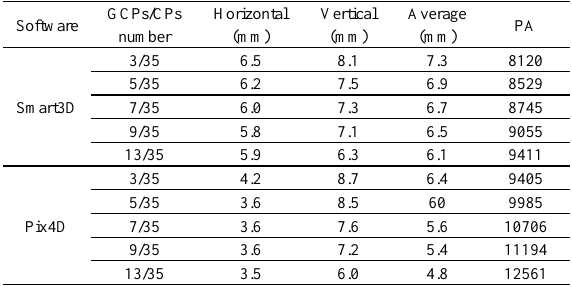
Table 5. Horizontal and vertical accuracies (H = 50 m)